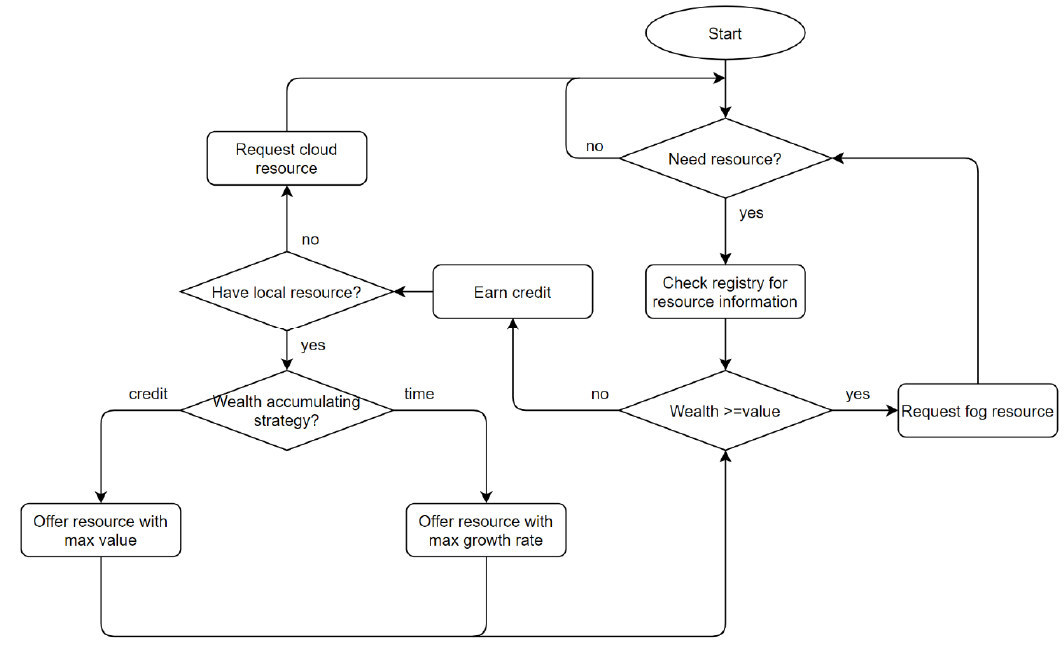
Figure 4. AFMIA algorithm.